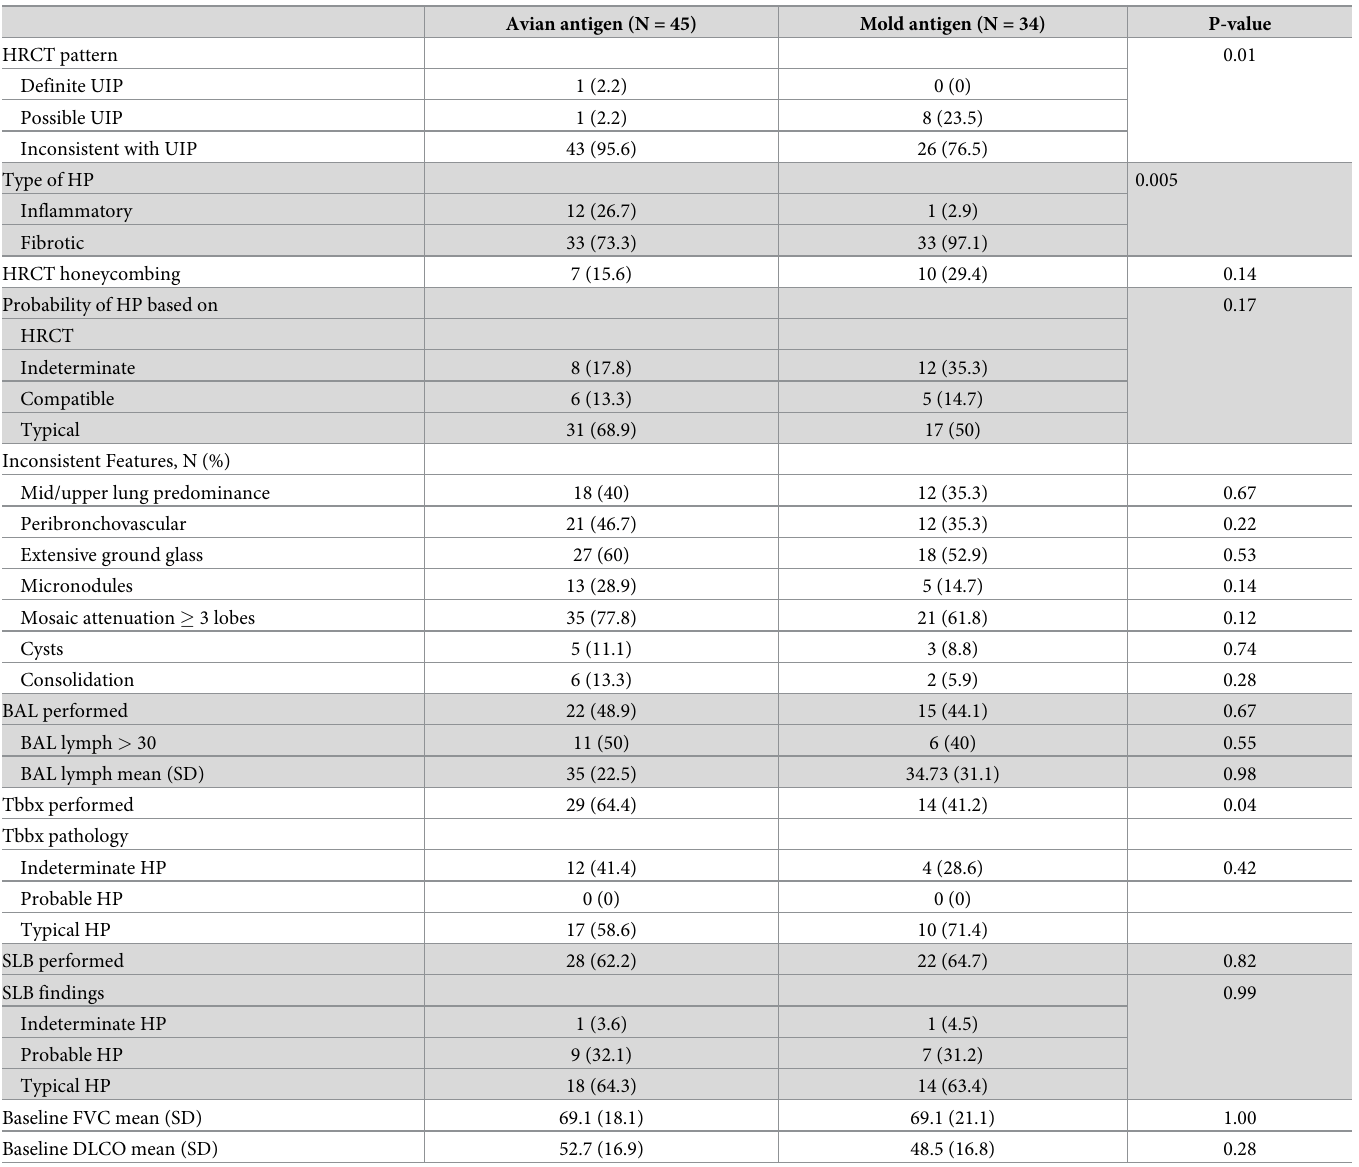
Table 5. Radiographic and histopathologic features by avian vs mold